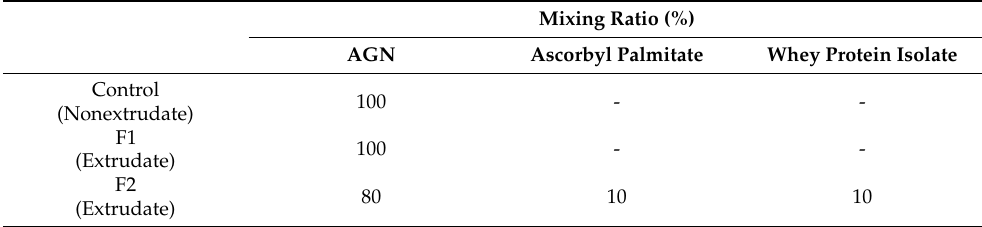
Table 1. The compositions of HME-AGN.